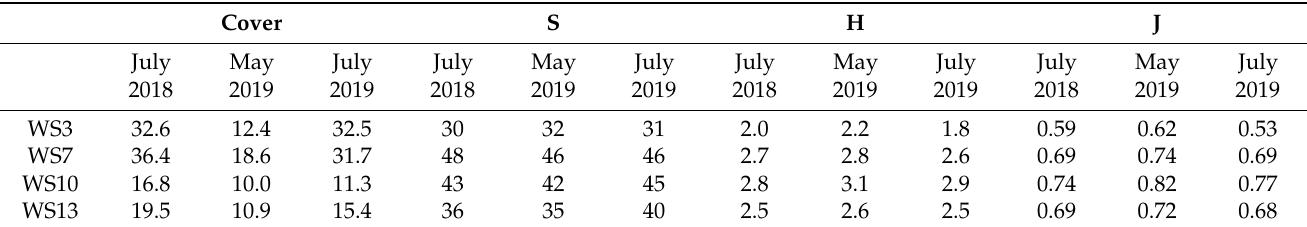
Table 3. Herb-layer cover (in m 2 of leaf area per 100 m 2 of ground), species richness (S), Shannon diversity (H), and Pielou’s evenness (J) at the watershed scale in each of the three sampling campaigns. Data are from the Fernow Experimental Forest, West Virginia,